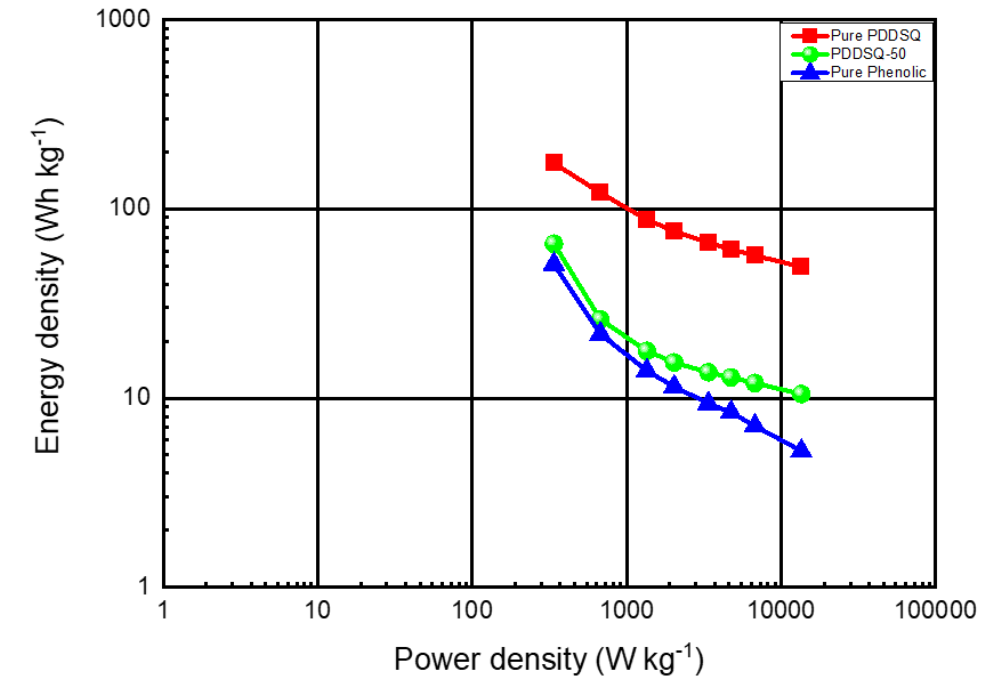
Figure 11. Ragone plots of the energy density and power density of the carbon/DDSQ hybrids derived from pure phenolic, PDDSQ-50, and pure PDDSQ.